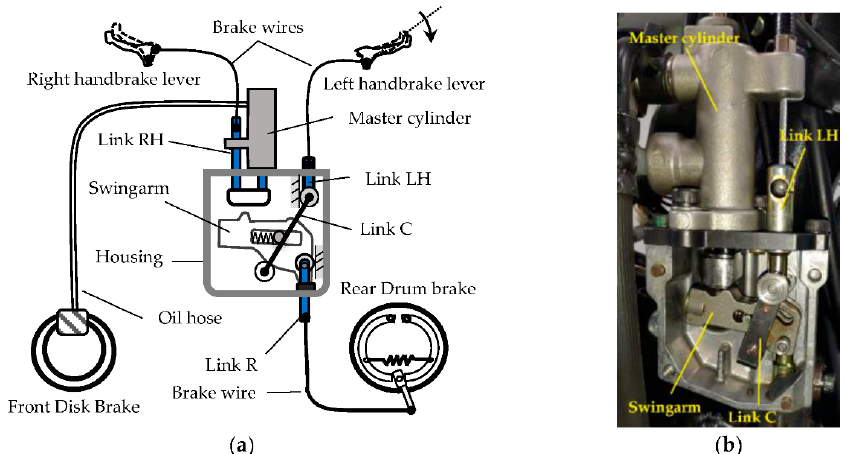
Figure 10. The layout of the VCBS prototype and the associated measurement system: ( a ) schematic; ( b ) photograph of the VCBS.